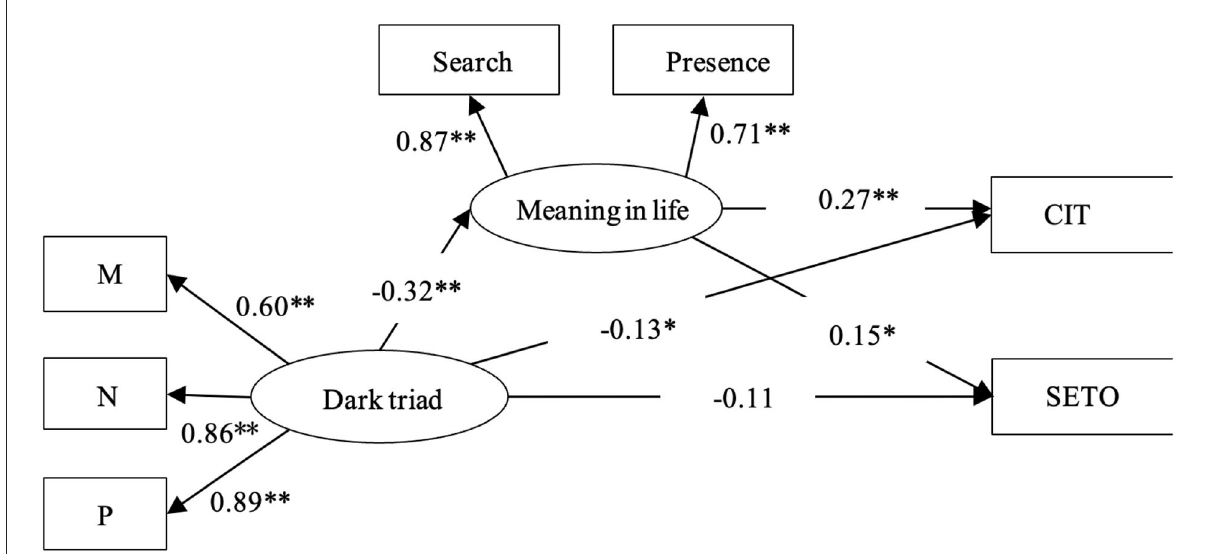
FIGURE1 The mediated model of meaning in life between DT and CIT and SETO. CIT, confidence in treatment; SETO, subjective evaluation of treatment outcomes. Numbers are standardized regression coefficients. * p < 0.05, ** p <